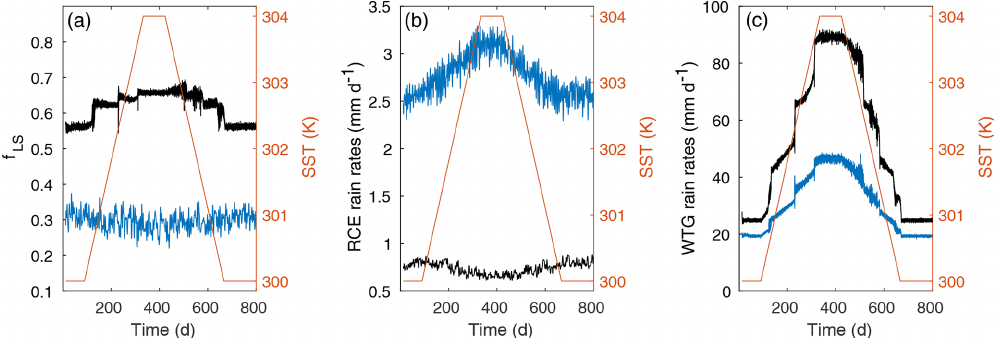
Figure 3. (a) The left axis shows f LS for the WRF SCM over 800d RCE (blue) and WTG (black) experiments. When running the SST- forcing experiment in an RCE configuration, the unfiltered f LS has an average value of ∼ 0 . 28 and a standard deviation of ∼ 0 . 18. (The presented RCE f LS data have been low-pass filtered for clarity.) (b) The left axis shows convective (blue) and large-scale (black) rain rates for the RCE experiment. These data have been low-pass filtered. (c) The left axis shows convective (blue) and large-scale (black) rain rates for the WTG experiment. The right axes for all plots give SST over the experiments. Table 1. A series of quantities averaged over the last 30d from 180d RCE and WTG approximation experiments without anomalous SST forcing. After f LS , the three types of precipitation (deep-convective P D , large-scale P LS , and shallow-convective P SH ) are shown, followed by the shortwave radiation to the surface (SWD), the outgoing longwave radiation from the ground (GLW), the outgoing longwave radiation at the top of the column (OLR), and the surface sensible (HFX) and latent (LH) heat fluxes. f